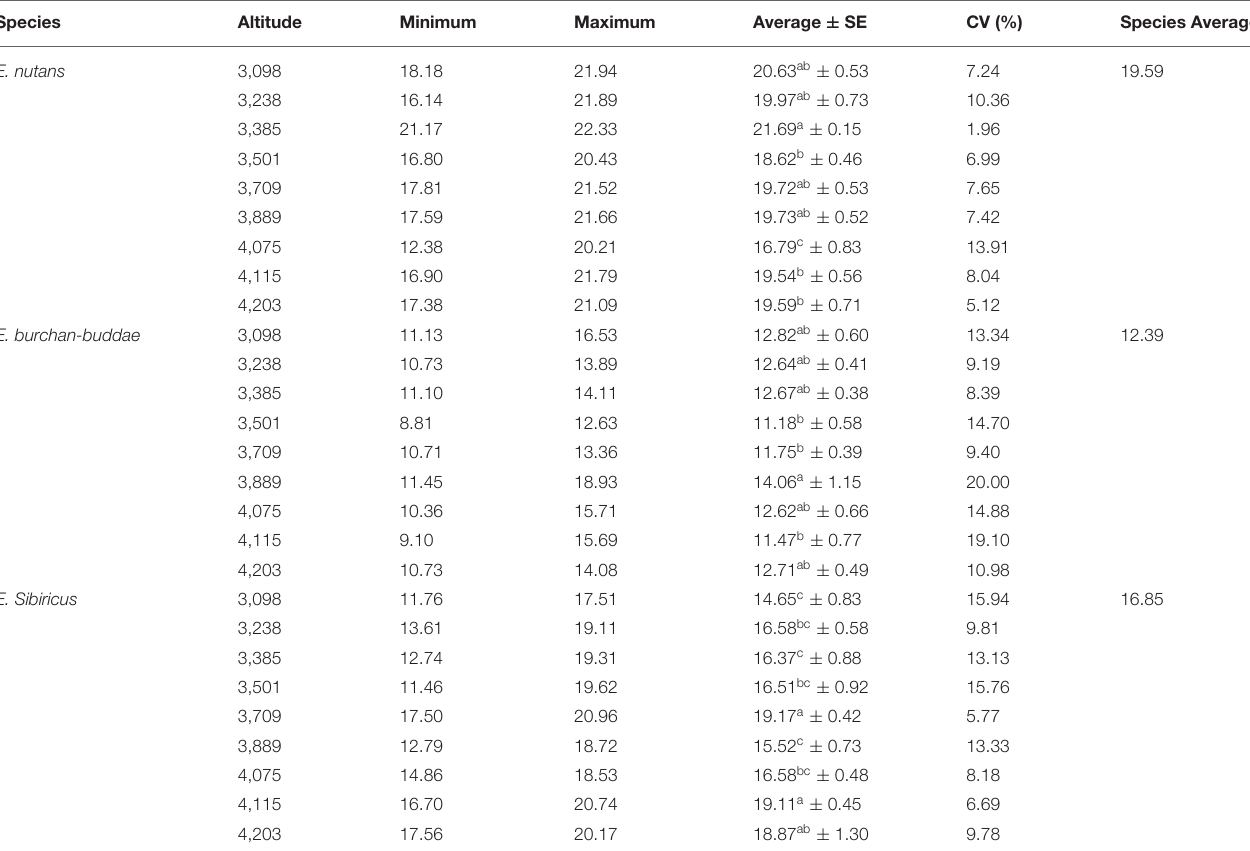
TABLE 1 | Nuclear DNA content (pg/2C) of three Elymus species in nine altitudes (between 3,098 and 4,203m). Species Altitude Minimum Maximum Average ± SE CV (%) Species Average